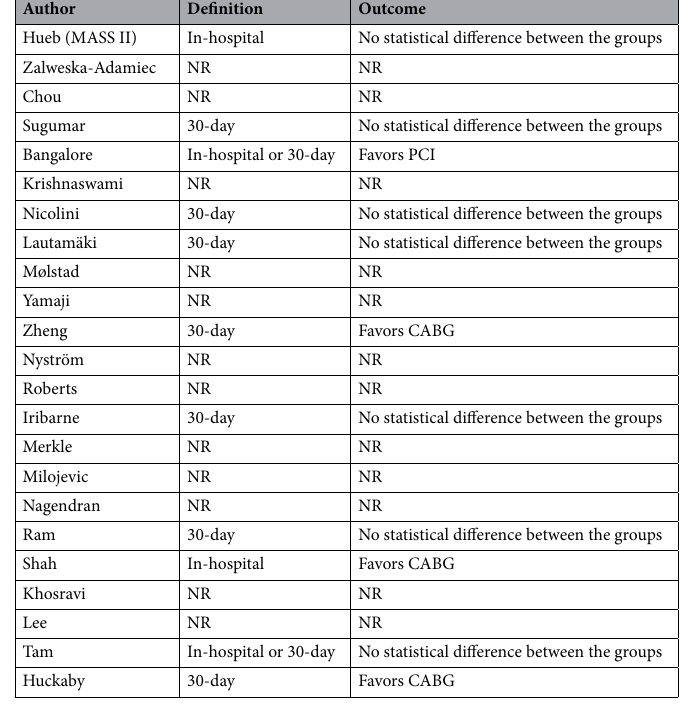
Table 5. Periprocedural mortality data from the selected studies. CABG coronary artery bypass grafting, PCI percutaneous coronary intervention, NR not reported.